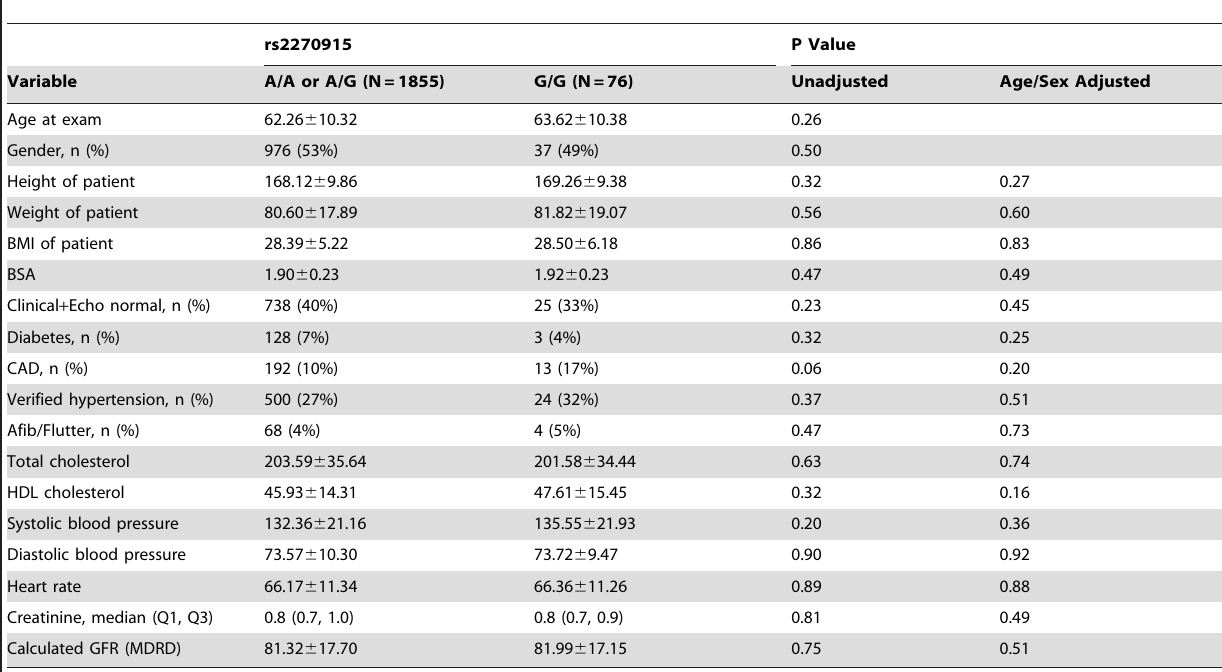
Table 1. Baseline Demographics of the Study Population Based on the rs2270915 Genotype.